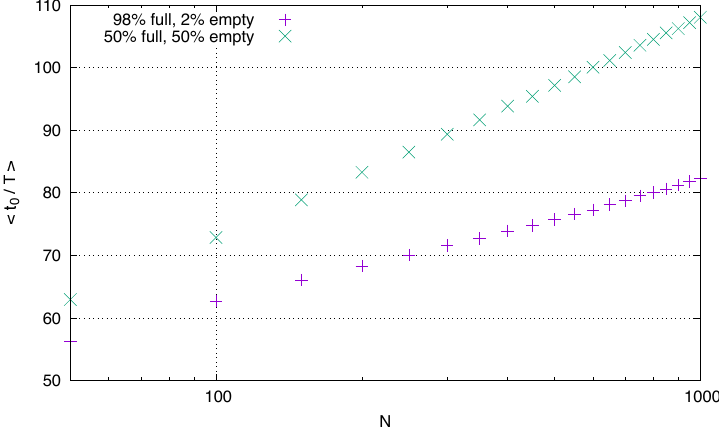
Figure 2. Distribution of times t 0 needed to reach equilibrium. Analogous distributions were obtained for different values of N and the average values computed. The resulting average time needed to reach equilibrium t 0 versus cloud size N is plotted in Figure 3 using logarithmic scale on the horizontal axis. In both cases we obtain a straight line (this is also true in the case of n ( 0 ) = 1 not plotted here). Thus, (cid:104) t (cid:105) ∝ log N . 0